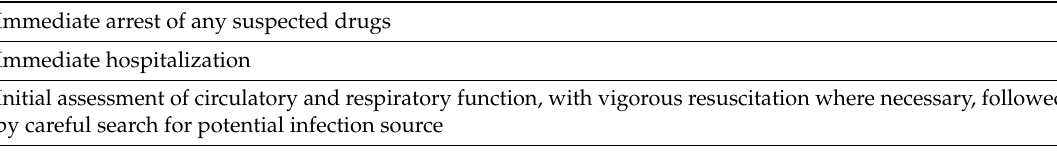
Table 6. Protocol for febrile neutropenia management in non-cancer